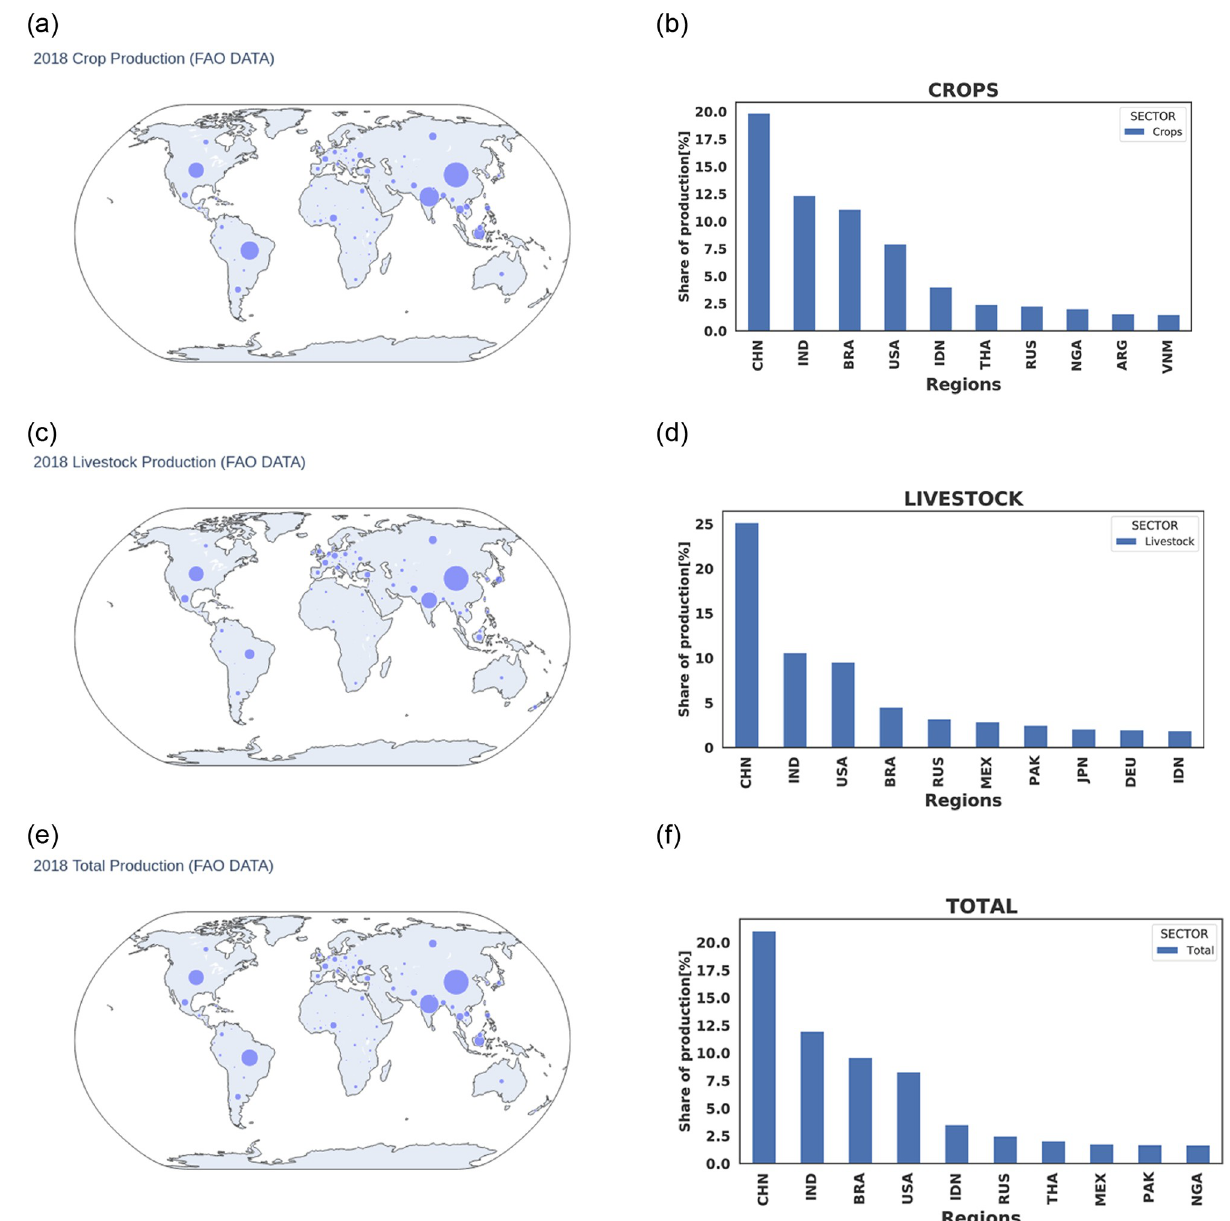
Fig 3. Share of aggregated agricultural production for the year 2018. This figure shows top agricultural producing countries. (a), (c), and (e) are bubble maps showing top crops, livestock, and total (crop + livestock) producing regions while (b), (d), and (f) are bar charts indicating top ten crop, livestock, and total (crop + livestock) producing regions. Names of countries in the bar charts are in ISO3 format. A list of country names, their ISO3 codes and continents can be found in Tables 6–9 in S1 File. The maps are generated using the Basemap package in python.